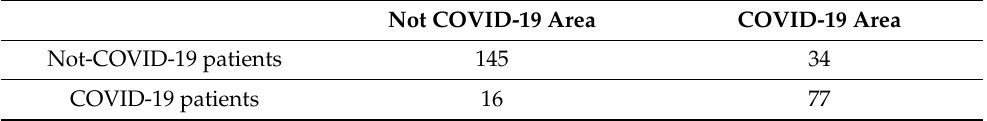
Table 6. Confusion matrix based on the logistic regression (binary classification). By row the actual patient status, by column their classification according to the